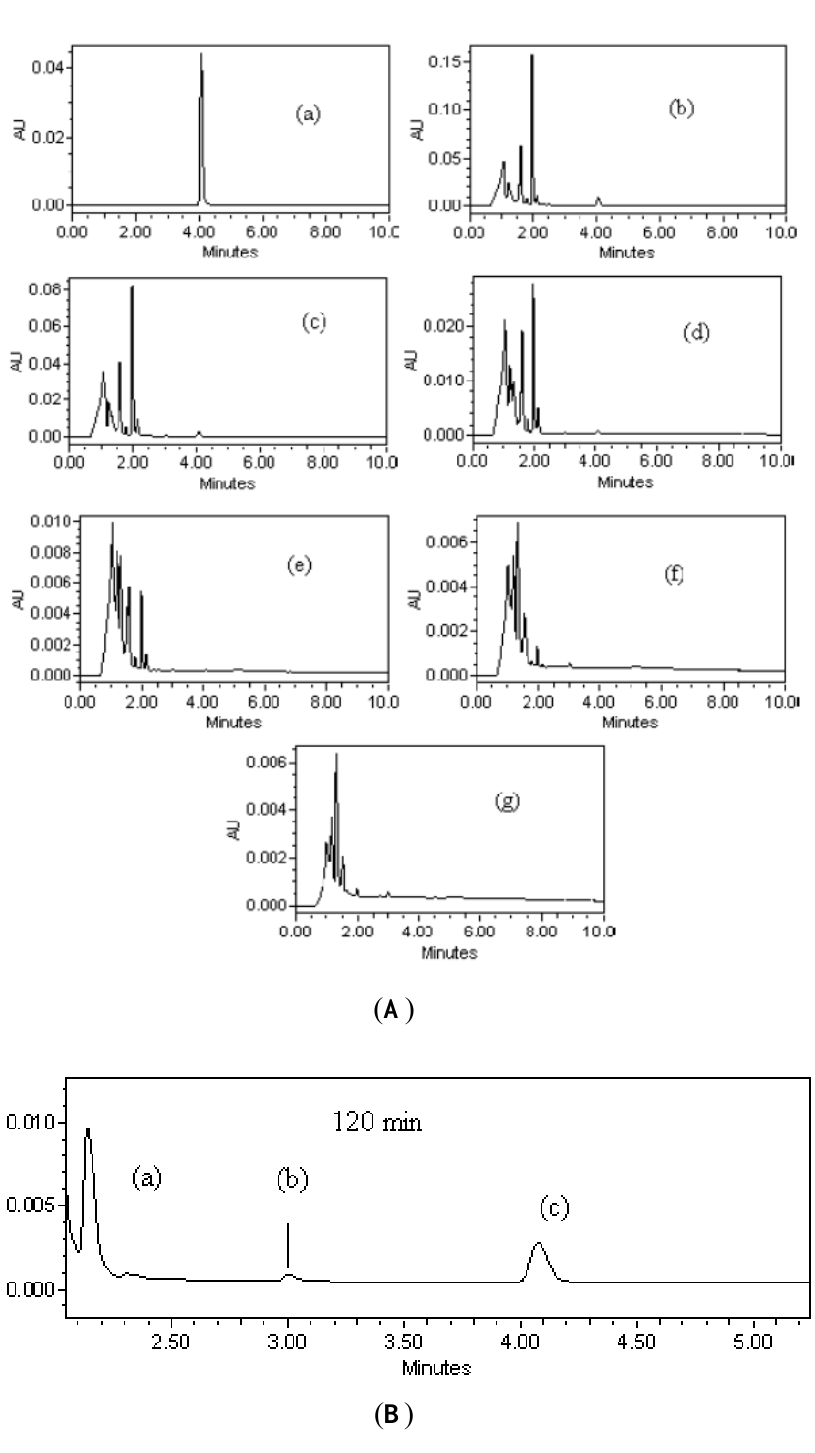
Figure 7. ( A ) P -cresol ultra high pressure liquid chromatography (UPLC) chromatograms depicting eluted peaks at different reaction times: ( a ) 0 min; ( b ) 60 min; ( c ) 120 min; ( d ) 180 min; ( e ) 240 min; ( f ) 300 min; ( g ) 360 min., initial condition: p -cresol concentration = 50 ppm; amount of ZnO = 2.5 g/L and pH 7.49. ( B ) Selected UPLC chromatograms of p -cresol that shows: (a) 4-hydroxy-benzaldehyde; (b) 4-methyl-1,2- benzodiol as intermediates; and (c) p -cresol. Concentration of p -cresol = 50 ppm at 120